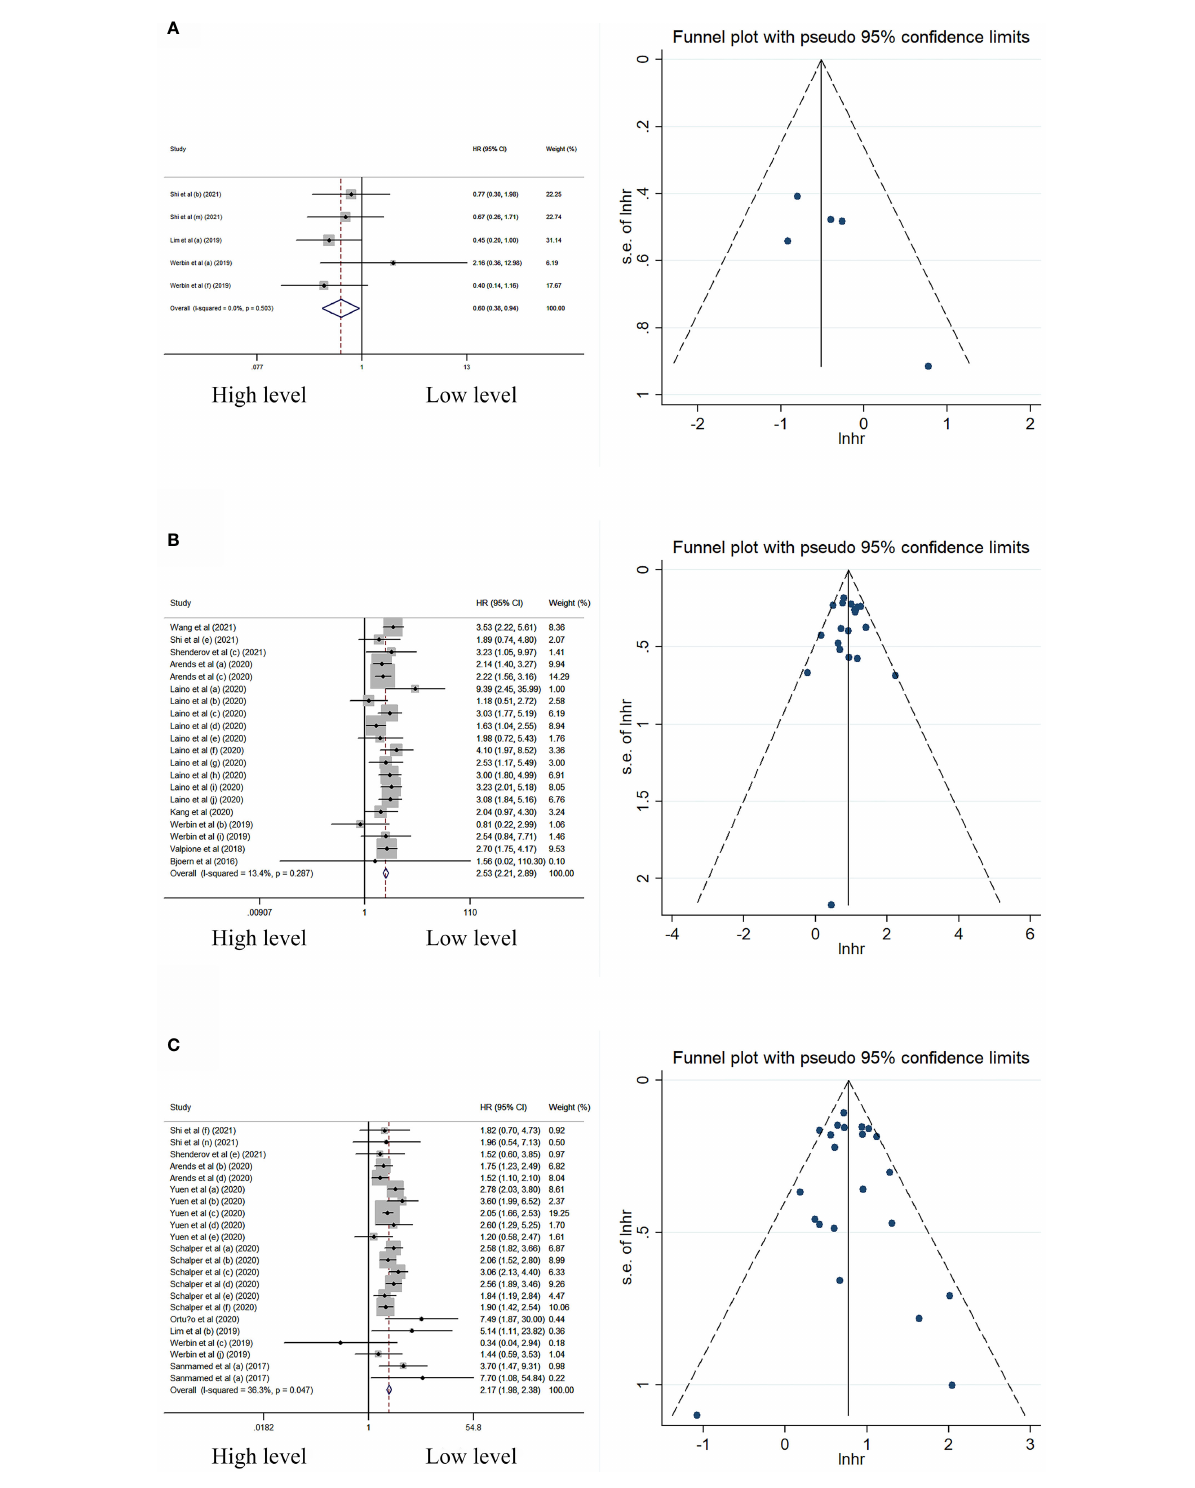
FIGURE 2 Forest plot and funnel plot of studies investigating levels of peripheral (A) IL-2, (B) IL-6, and (C) IL-8 in univariate analysis of